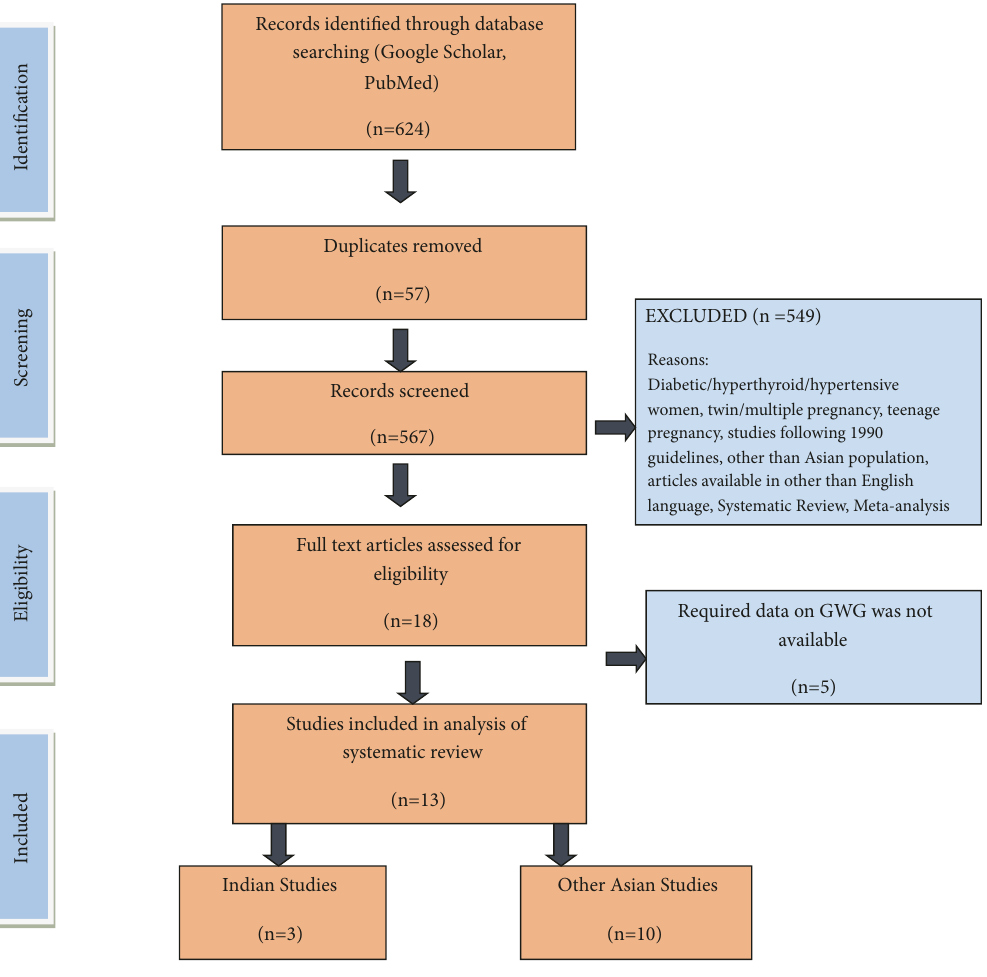
Figure 1: Flow diagram of study selection